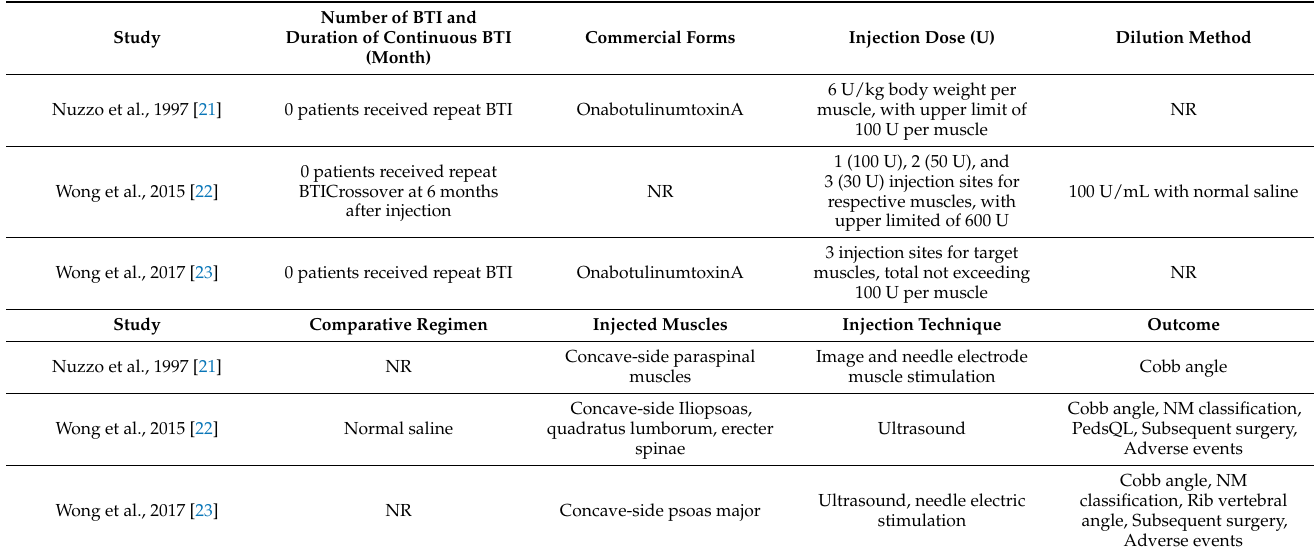
Table 2. The summarized extracted data from the included